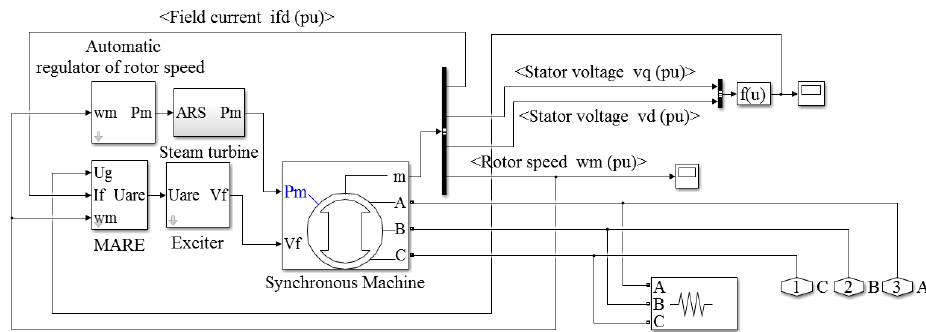
Figure 6. Flow chart of the MATLAB model of the mini CHPP.